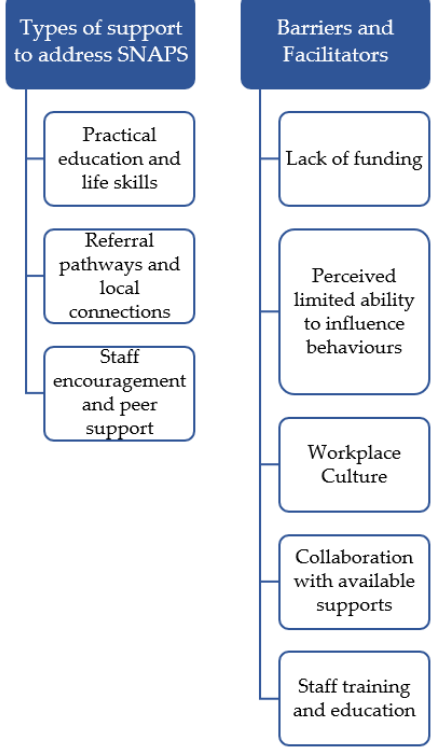
Figure 1. Theme map.